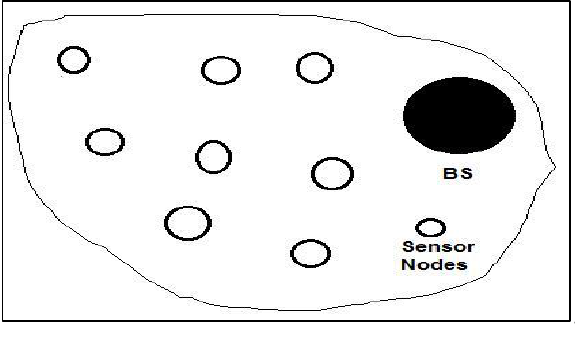
Figure 1. WSN’s components.